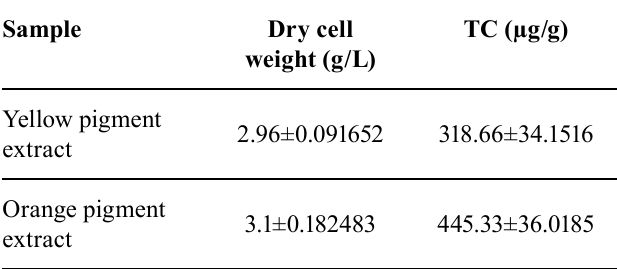
TABLE III – Total Carotenoid (TC) content of the yellow and orange pigment